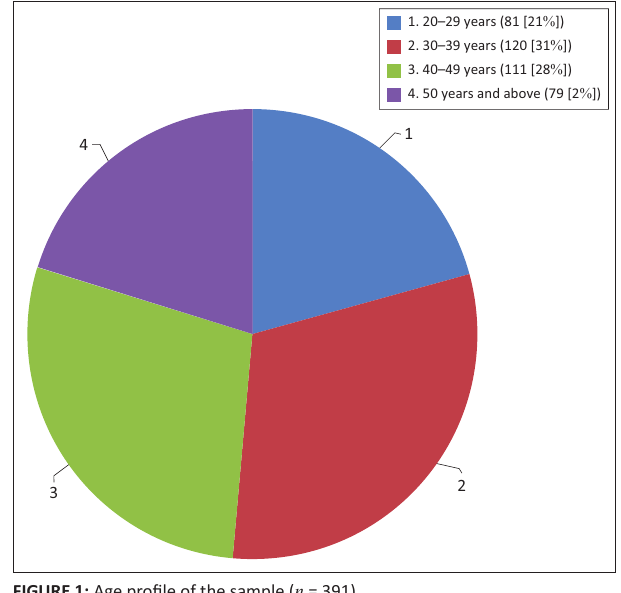
FIGURE 1: Age profile of the sample ( n = 391).